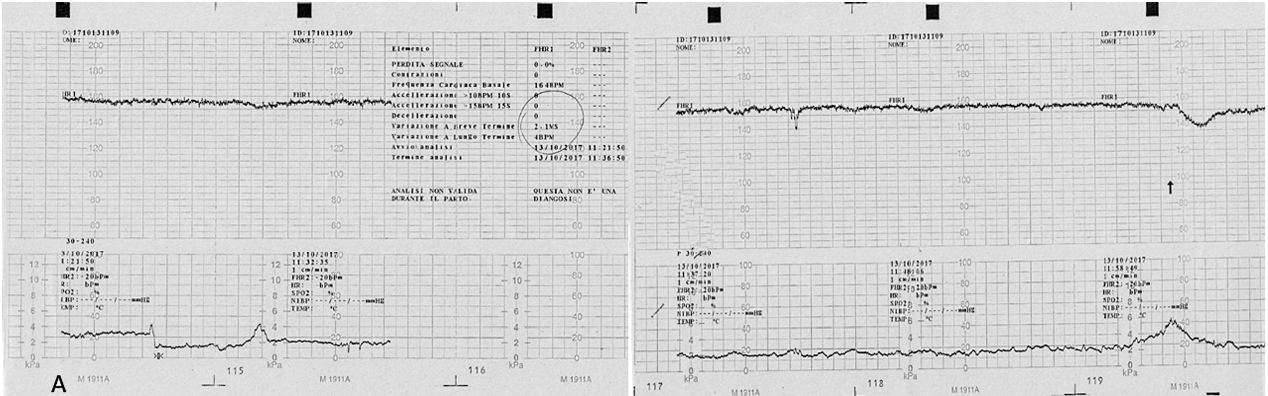
Figure 2. Doppler ultrasound revealed abnormal venous flow of the ductus venosus (DV) with a PI: 1.25. These findings were suspicious for metabolic, infective and/or hypoxic-ischemic events.